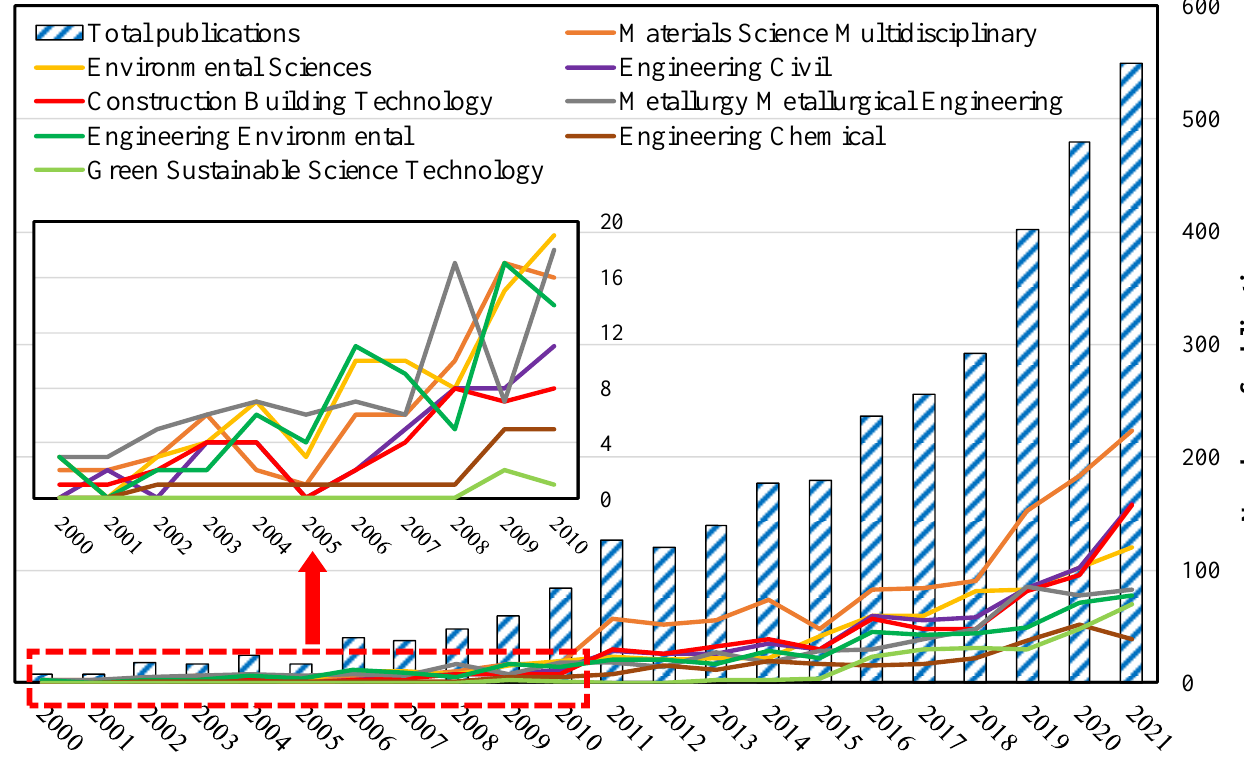
Figure 2. The annual number of publications of the main research categories and their total.